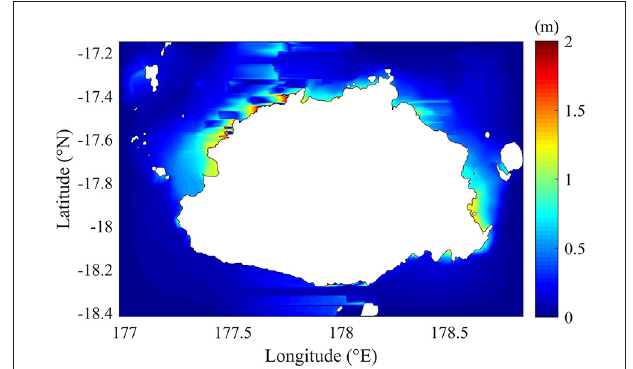
FIGURE 7 | Spatial distribution of the maximum storm surge level combining different wind directions (unit: m above